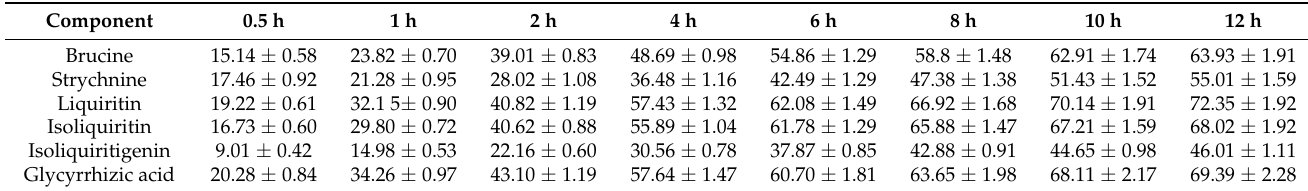
Table 4. Percentage of cumulative release in distilled water (mean ± SD, %).